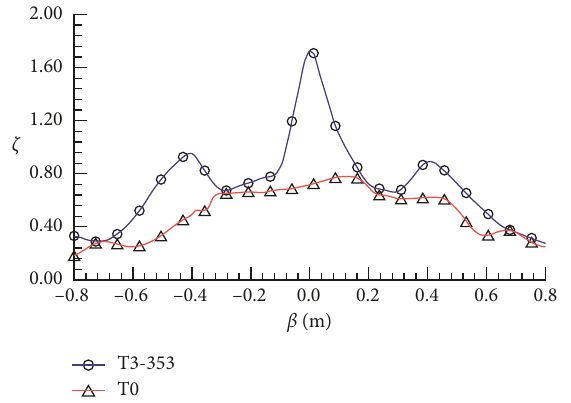
Figure 21: Variation of dissipation rates on L